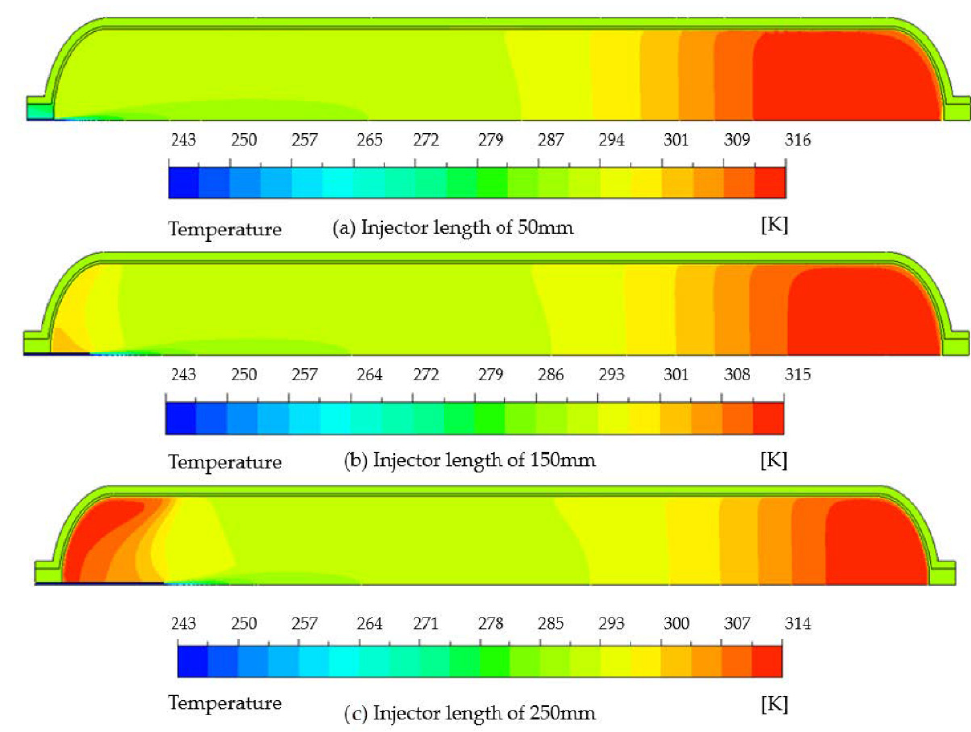
Figure 12. Effect of injector length on the temperature distribution of hydrogen tank.